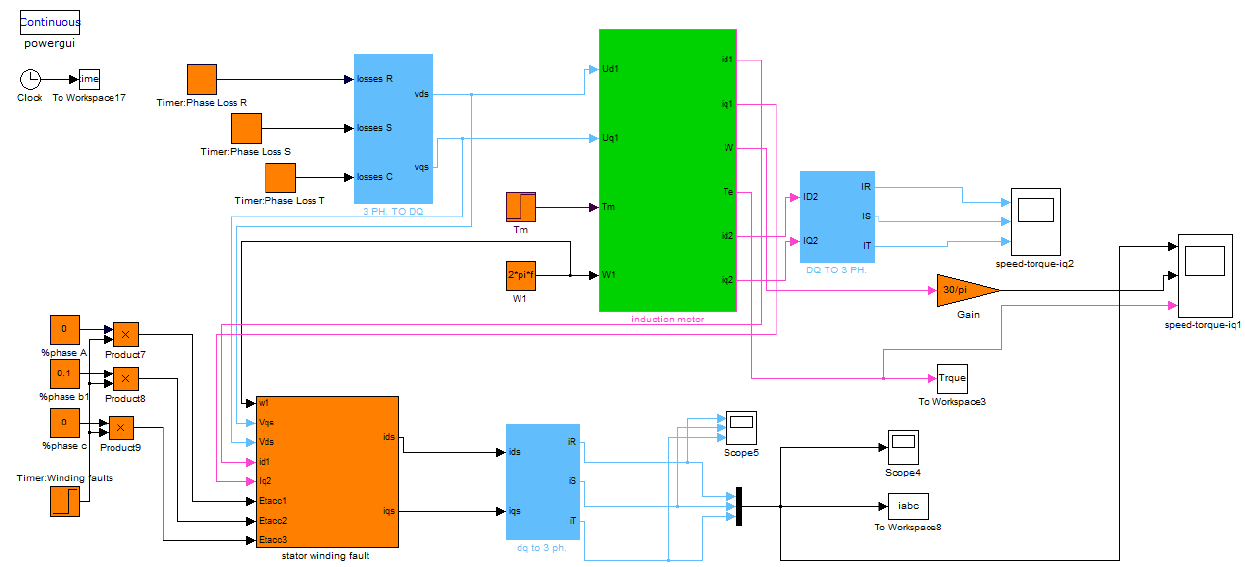
Figure 4. Simulink block diagram of the inter-turn.